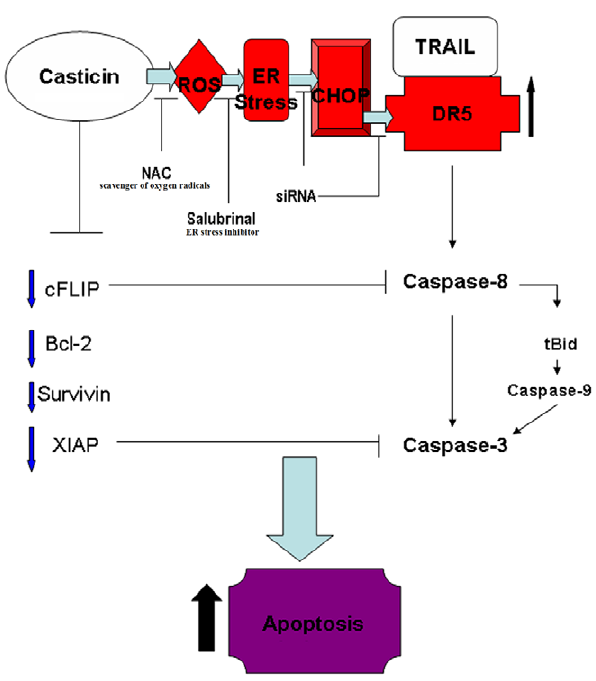
Figure 9. The proposed mechanism of enhanced apoptosis by a combination of casticin and TRAIL in gastric cancer cells. Casticin initially promotes ROS generation and triggers ER stress, then induces DR5 upregulation through the activation of CHOP which then enhances TRAIL-induced activation of DR5-induced and mitochondria- mediated apoptosis pathways. Simultaneously, casticin facilitates TRAIL- induced apoptotic cell death by inhibition of anti-apoptosis protein (cFLIP, Bcl-2, survivin and XIAP) expression and activation of pro- apoptosis proteins.